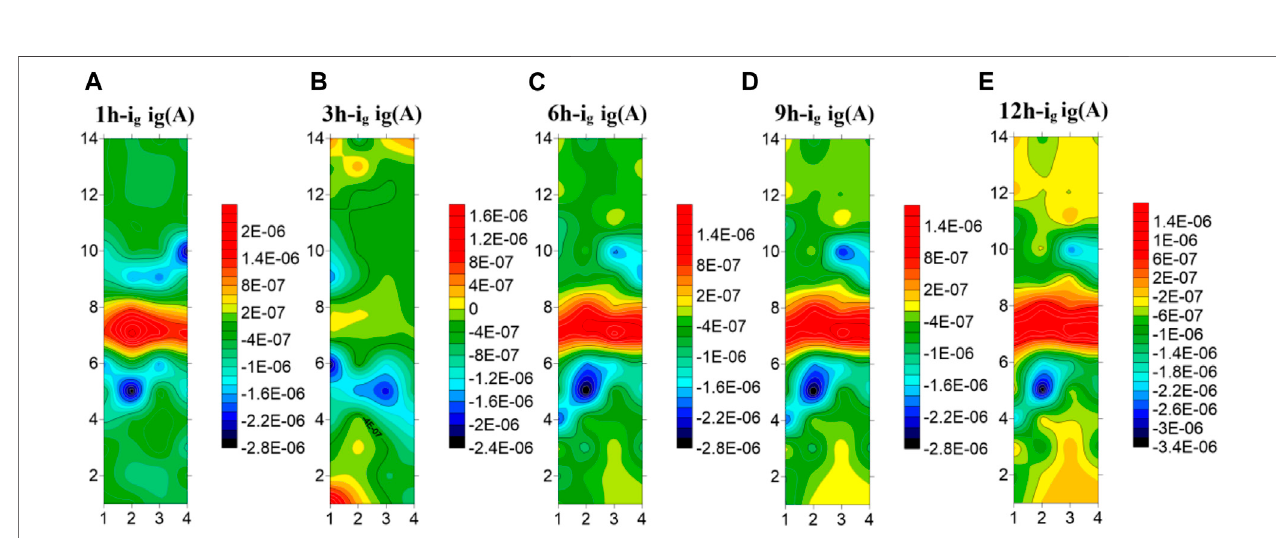
FIGURE 8 | Microelectrode array test results of titanium alloy welded joint soaked in seawater for 12 h at 35 ° C (A) 1 h (B) 3 h (C) 6 h (D) 9 h (E) 12 h.